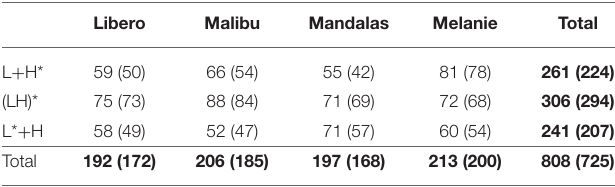
TABLE 3 | Number of responses split by experimental item and intonation condition.